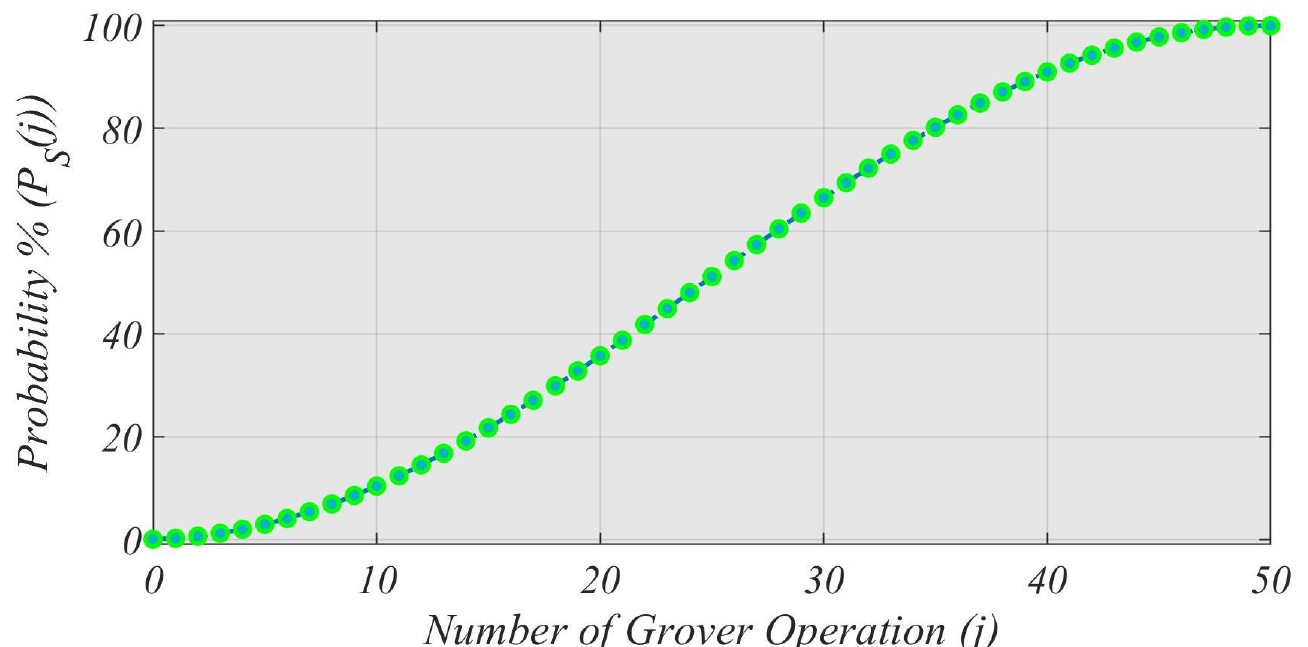
Figure 6. The probability of the state of the solution ( | 010010001000 (cid:105) ) after j Grover operator.